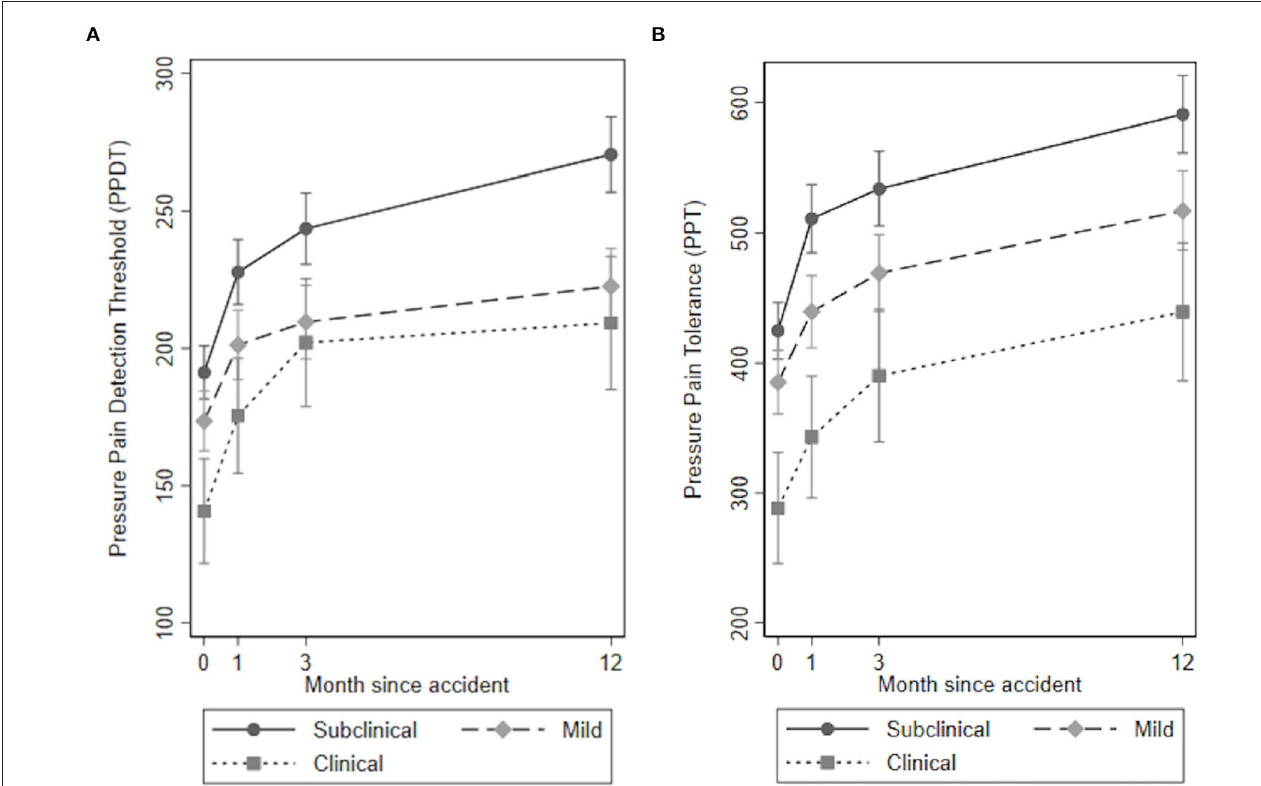
FIGURE 1 | (A,B) Pressure pain detection threshold (PPDT) and pressure pain tolerance (PPT) by posttraumatic stress symptoms (PTSS) groups over time.